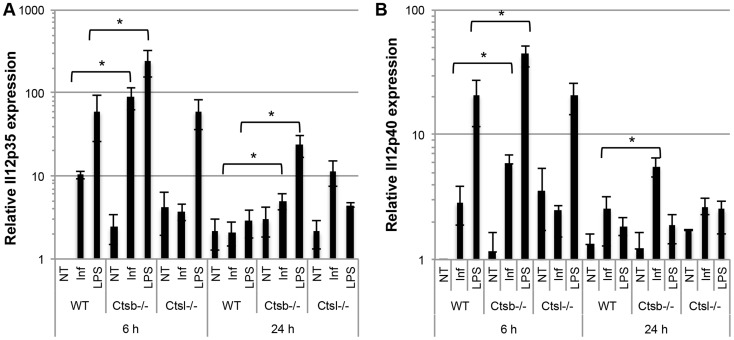
IL-12 is up-regulated at the transcriptional level in BMM from cathepsin B-deficient mice in response to L. major infection and LPS stimulation.Relative expression levels of (A) IL-12p40 and (B) IL-12p35 transcripts in mRNA from BMM at 6 hours or 24 hours p.i. with L. major promastigotes or LPS stimulation. Non-treated (NT) BMM from each mouse line were used as negative controls. The expression levels were estimated using the 2− ΔΔC
T method, using WT NT BMM at t = 6 hours as a reference. The results are shown as mean ± SD of 4 independent experiments, * p<0.05.